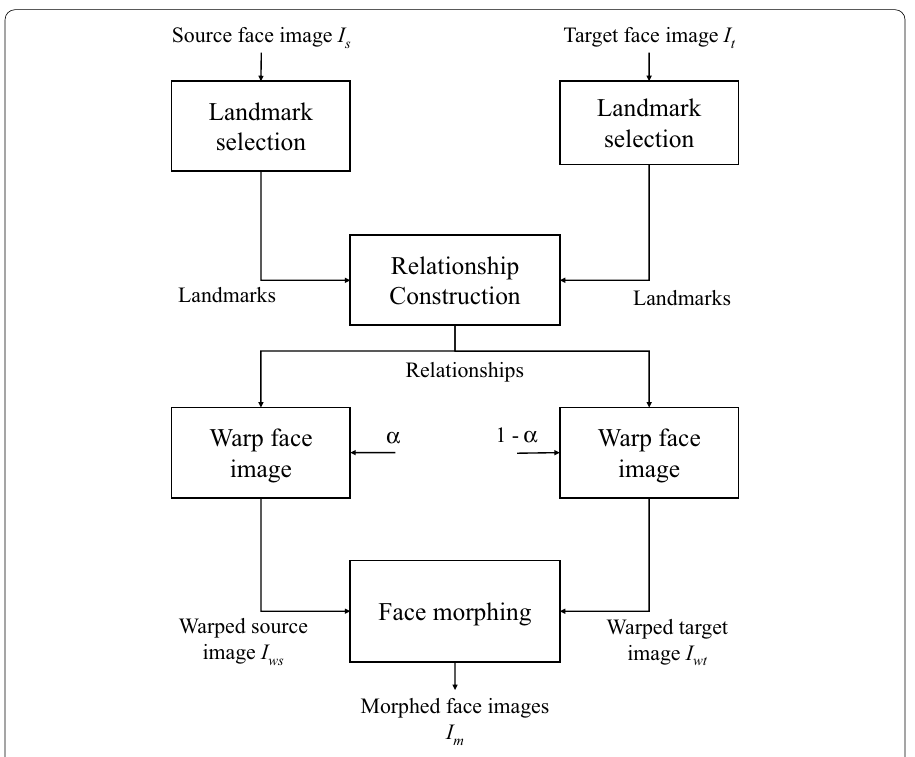
Fig. 3 The overall flowchart of the proposed face morphing